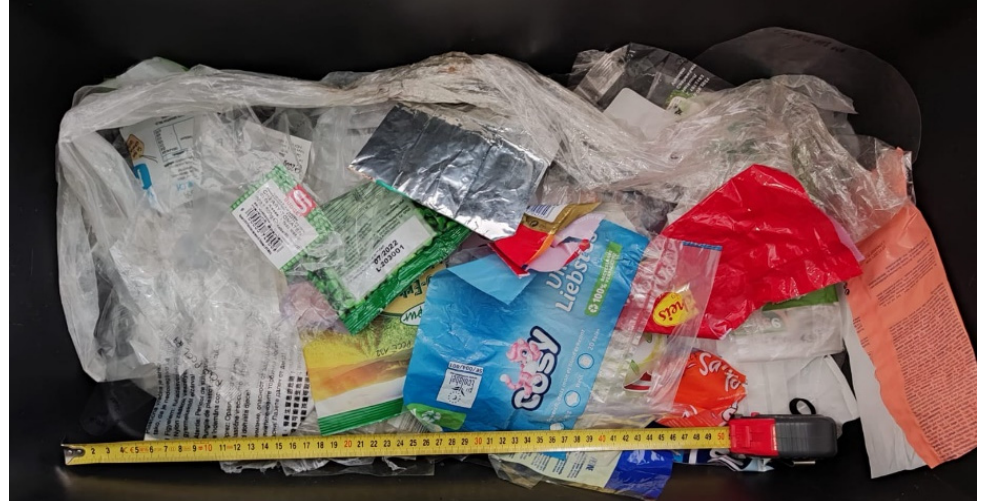
Figure 1. Fraction of small films waste.